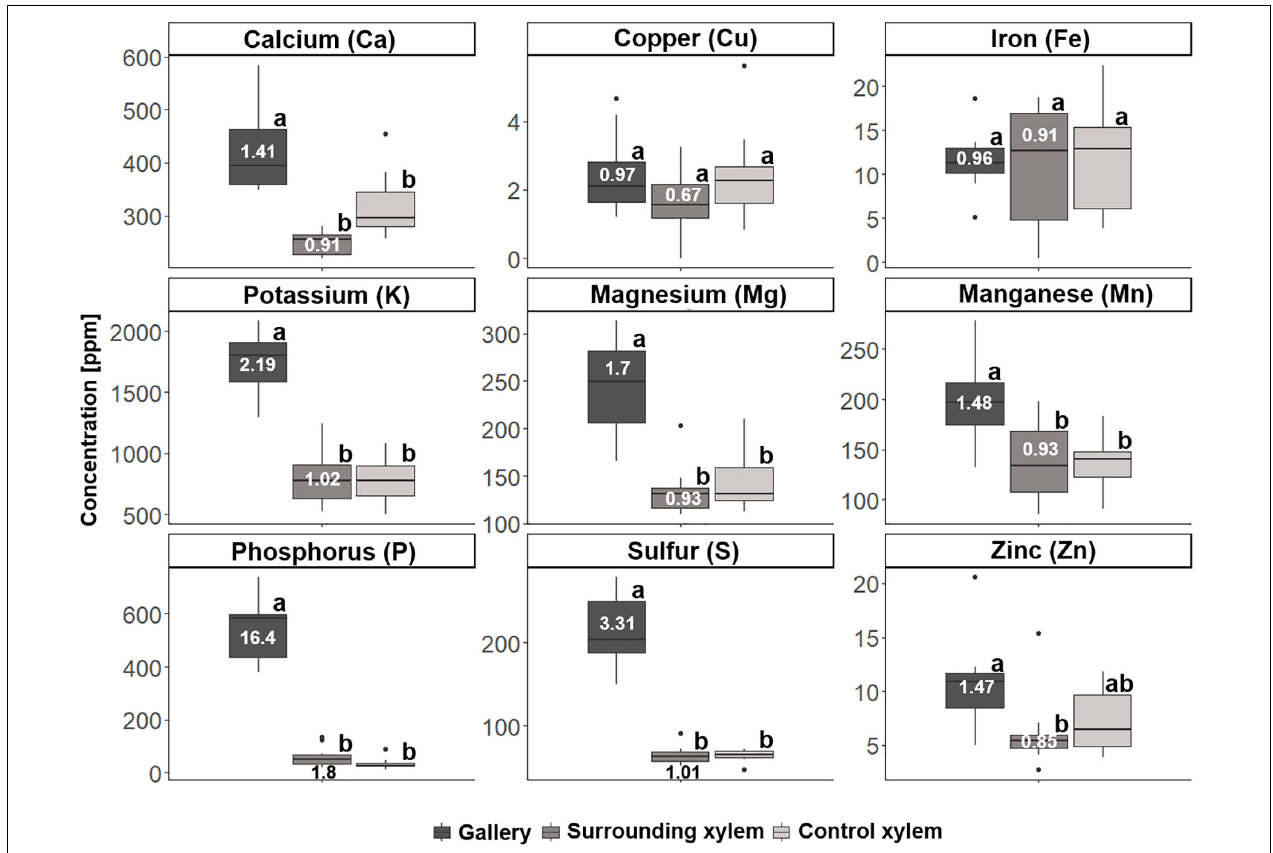
FIGURE 6 | Concentrations of the different elements for the three types of samples taken from galleries of Xyleborinus saxesenii ( N = 9–10 per group): (i) gallery, (ii) xylem next to gallery, and (iii) control xylem. Elemental abundances are given in parts per million (ppm). Different letters next to boxplots (a, b) indicate significant differences between the respective group per individual element. Enrichment ratios (white numbers) for treatment i and ii were added to boxplots for each element. For P and S, enrichment rations were indicated below the boxplot (black